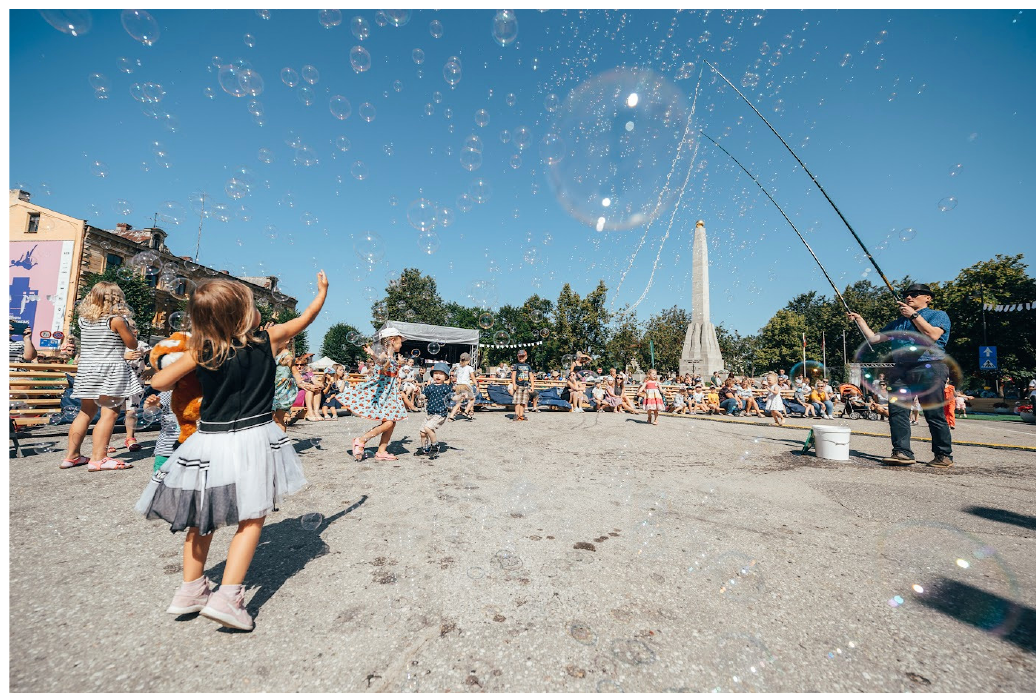
Figure 9. Annual city festival in Vienības Square, 2019. Source: Courtesy of Cēsis Municipal